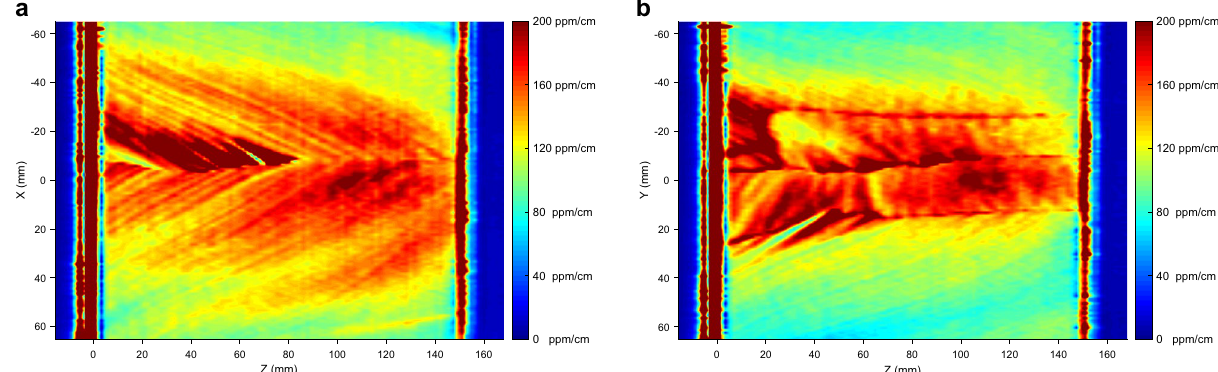
Figure 2. Rectangular absorption maps of the sapphire substrate on the XZ plane (a) and YZ plane (b) . The dark blue areas correspond to the 0 absorption outside the sample. On the surfaces, there is a large absorption that saturates on the